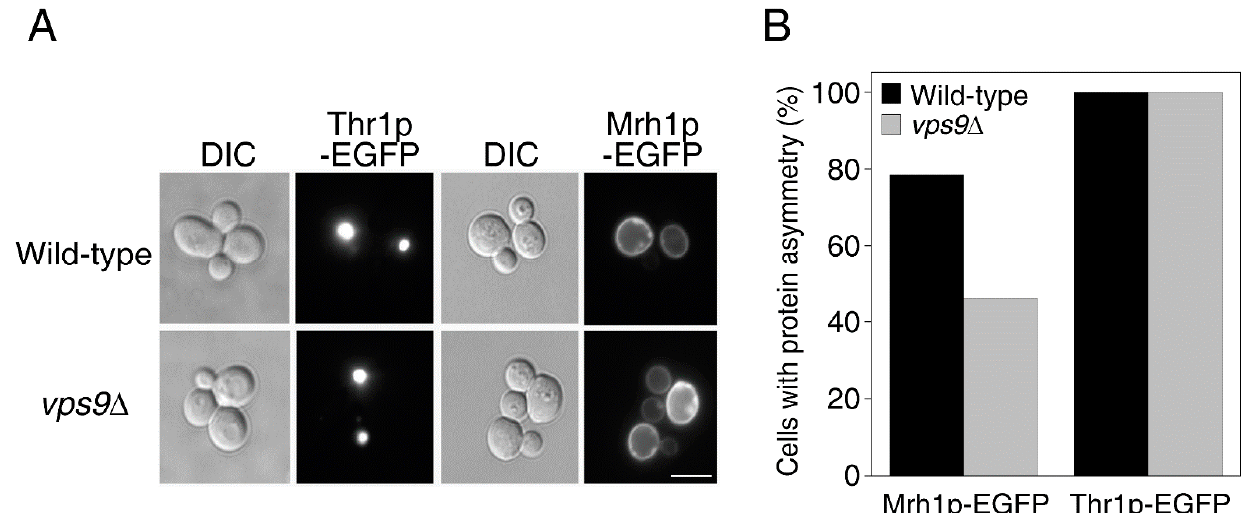
Figure 3. Deletion of VPS9 disrupts the asymmetry of Mrh1p, a plasma membrane protein, but that of Thr1p, a cytoplasmic protein. Wild-type or vps9 Δ cells were transformed with plasmid DNA encoding Thr1p-EGFP or Mrh1p-EGFP and analyzed for EGFP fluorescence by fluorescence microscopy. More than 100 cells were analyzed, and representative images ( A ) and their quantitation ( B ) are shown. Scale bar: 5 μ m.